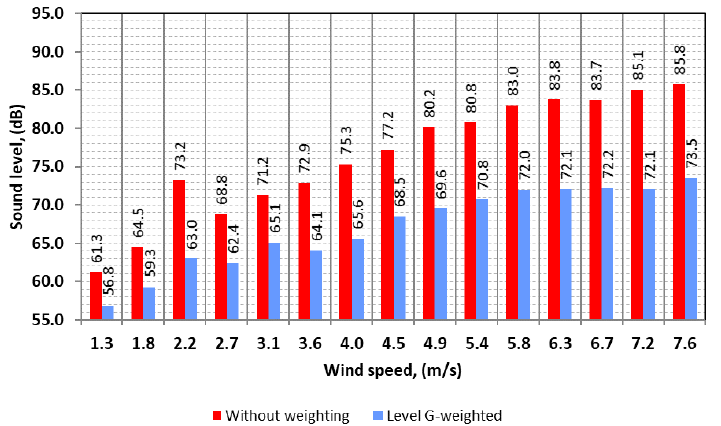
Figure 11. Comparison of variations in noise levels in the function of wind speeds—T2